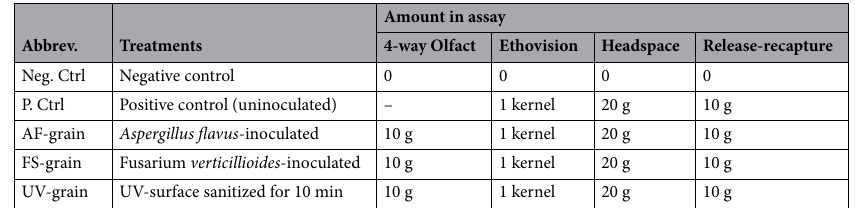
Table 2. List of semiochemical treatments and the amounts used in each assay during the study.